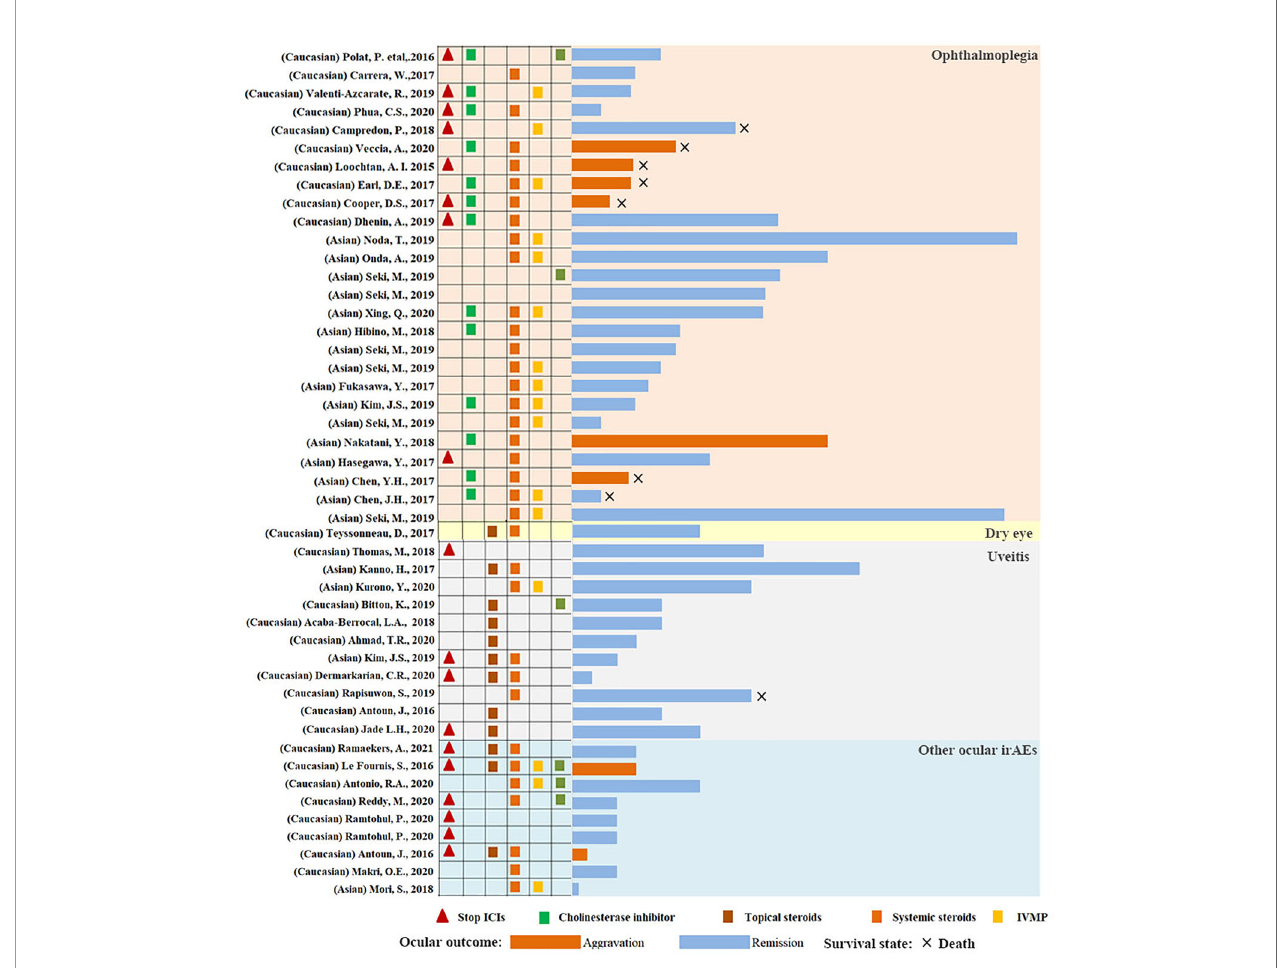
FIGURE 4 | The course of the ocular irAEs following ICI use in lung cancer. The column indicates the length of the complication in each patient with ocular irAEs. Light pink, light gray, light yellow, and light blue represent ophthalmoplegia, uveitis, dry eye, and other ocular irAEs. The blue column represents remission or complete recovery. The dark yellow column represents an aggravation of disease or